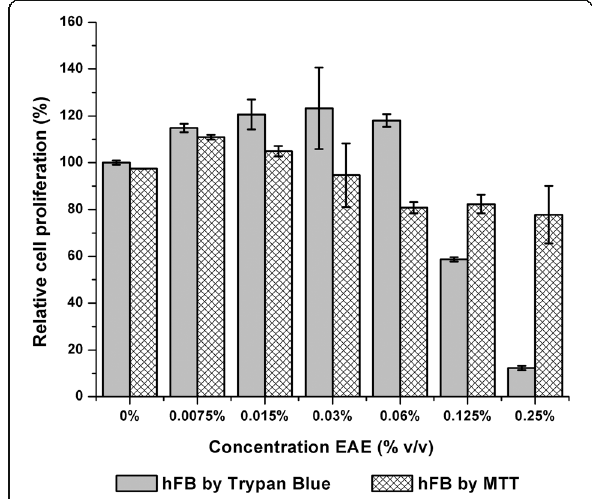
Fig. 6 Comparative of relative cell proliferation percentage of hFB cell line in the ethanolic extract (EAE) by MTT and Trypan blue test. Error bars represent standard